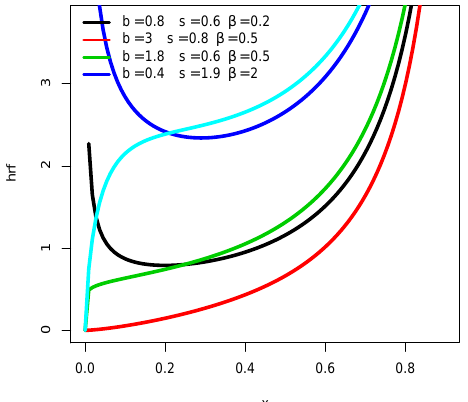
Figure 2. Plots of h UG / G ( x ; b , s , β ) for several values of b , s , and β